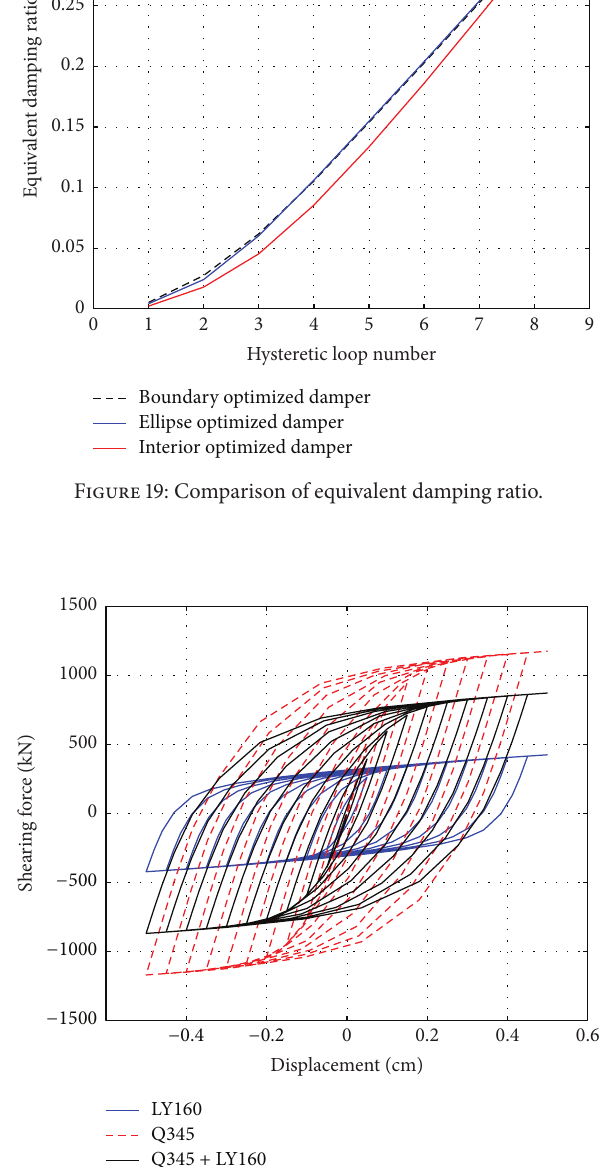
Figure 20: Hysteresis curves of interior optimized